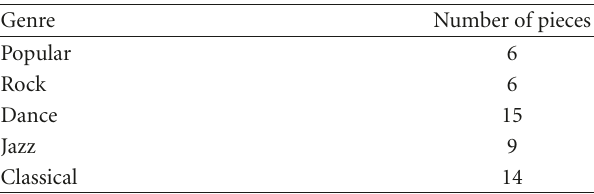
Table 3: Number of musical pieces for each